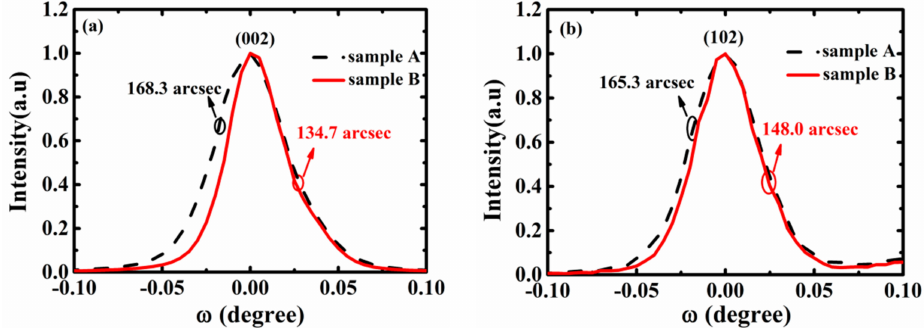
Figure 2. High-resolution XRD (HRXRD) ω -scans of the ( a ) (002) reflection and ( b ) (102) reflection for both